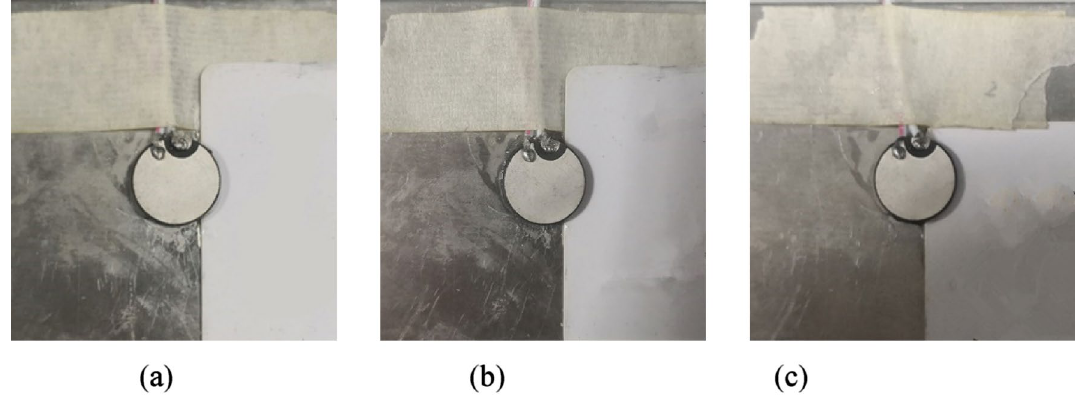
Figure 5. Debonding of 2# PZT: ( a ) 10% debonding; ( b ) 20% debonding; ( c ) 30% debonding.